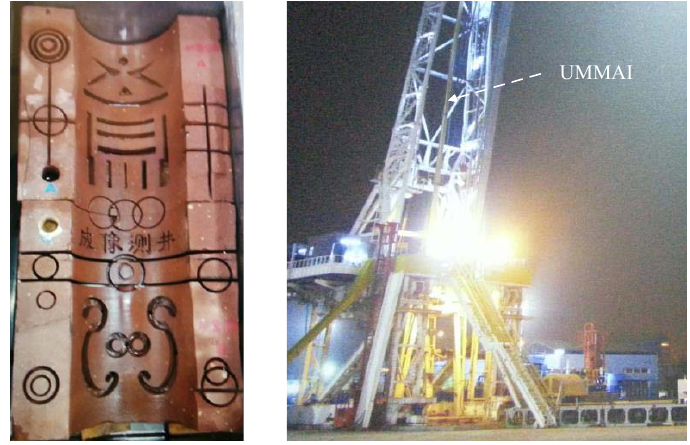
Figure 10. The field test setup of UMMAI. The left is patterns on the simulated borehole wall. The right is the test scenario of